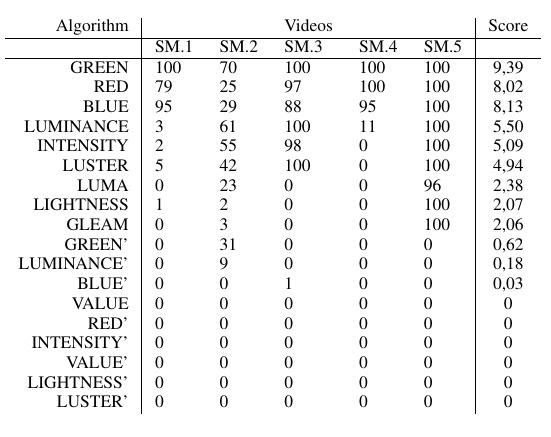
TABLE VIII T EMPLATE 2: % OF TRACKED FRAMES AND THE SCORE